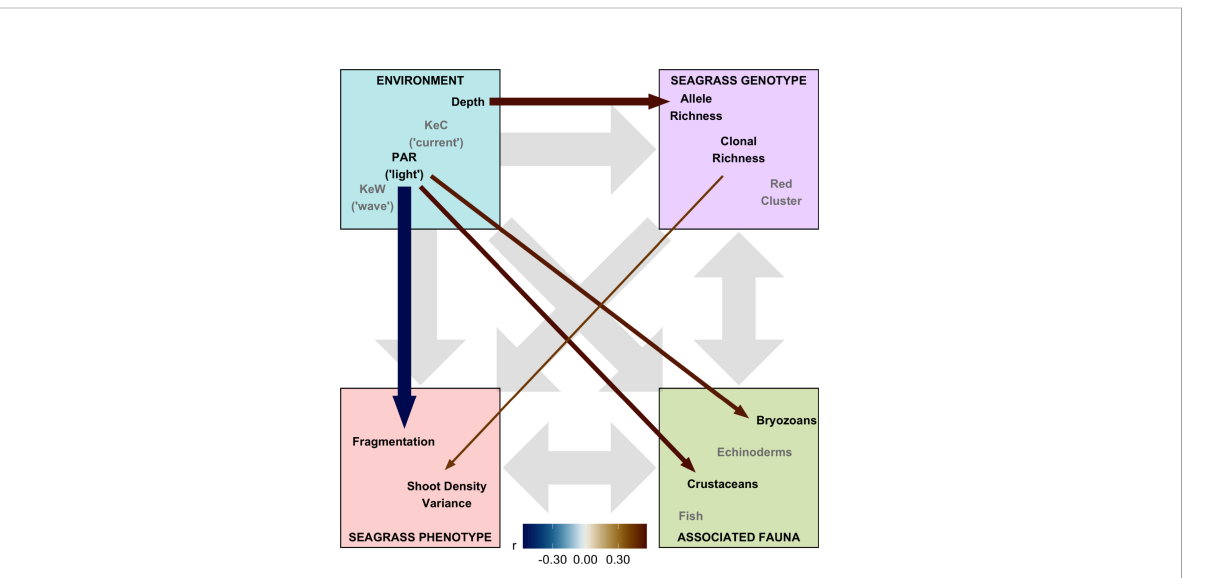
FIGURE 5 Structural equation model (SEM) schematic representation of Zostera marina ecosystem linkages from 17 locations across the south coast of England. Thirteen covariates were assigned to four ecosystem components: “ environment, ” “ seagrass genotype, ” “ seagrass phenotype, ” and “ associated fauna. ” Gray background arrows show assumed causal or bidirectional associations between ecosystem components. Covariates shown with black text were those found to have statistically signi fi cant associations with other components within our SEM ( p < 0.01), and the remaining covariates in the model are shown with gray text. Colored foreground arrows show the magnitude and direction ( − ve blue, red +ve) of associations, with arrow width scaled by statistical signi fi cance (smaller p -value shown as wider